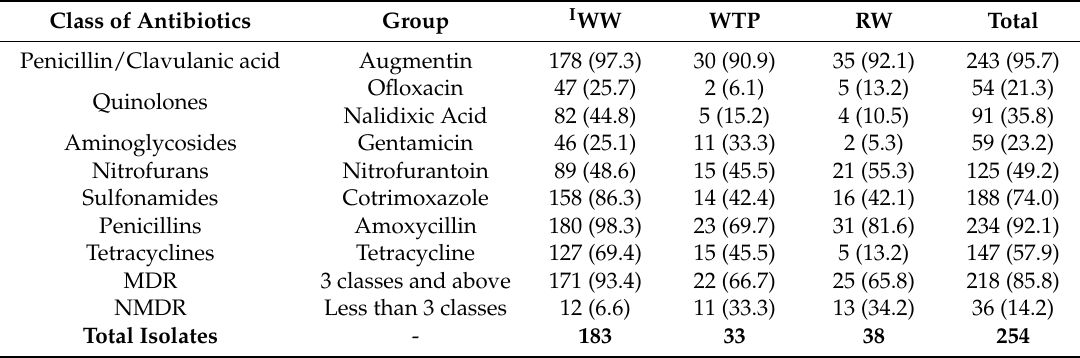
Table 3. Sensitivity of the bacteria isolated from different wastewaters (WW and WTP) and river water (RW) to selected antibiotics using the Kirby–Bauer disc diffusion method. Class of Antibiotics Group I WW WTP